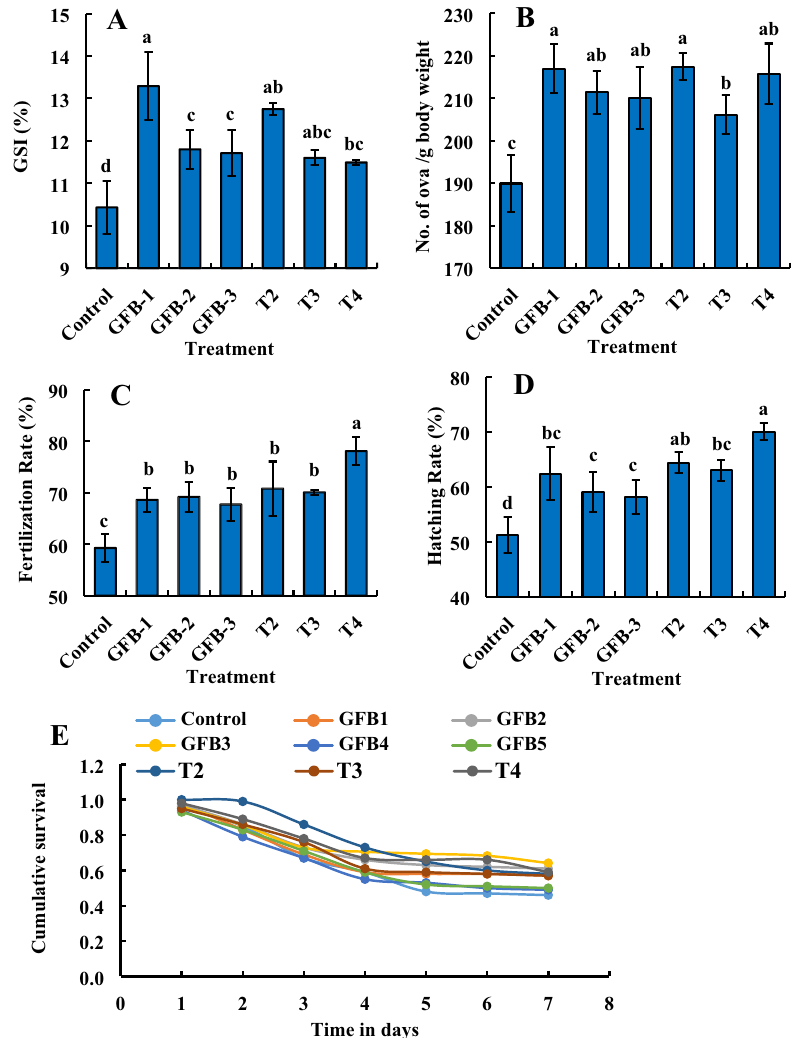
Figure 12. Comparative study between assessment of individual effects of five probiotic bacterial strains viz. GFB-1, GFB-2, GFB-3, GFB-4 and GFB-5 and consortium effects of five bacterial strains viz T2, T3 and T4 isolated from the gut of B. gonionotus on reproductive performances (A, B, C, D and E) of the host fish. One way ANOVA was performed for analyzing the data of three replicated experiment and data in column varies significantly in LSD at P < 0.05 (Statistix 10). Different letter bars indicate significant variations in GSI, no. of ova/ g body weight, fertilization rate, and hatching rate (n = 100) of hatchlings of the host fish in different groups by the isolates at P < 0.05 (Statistix 10). Cumulative survival of larva with a 95% CI was performed for survival analysis. Error bar = ± SD; n =